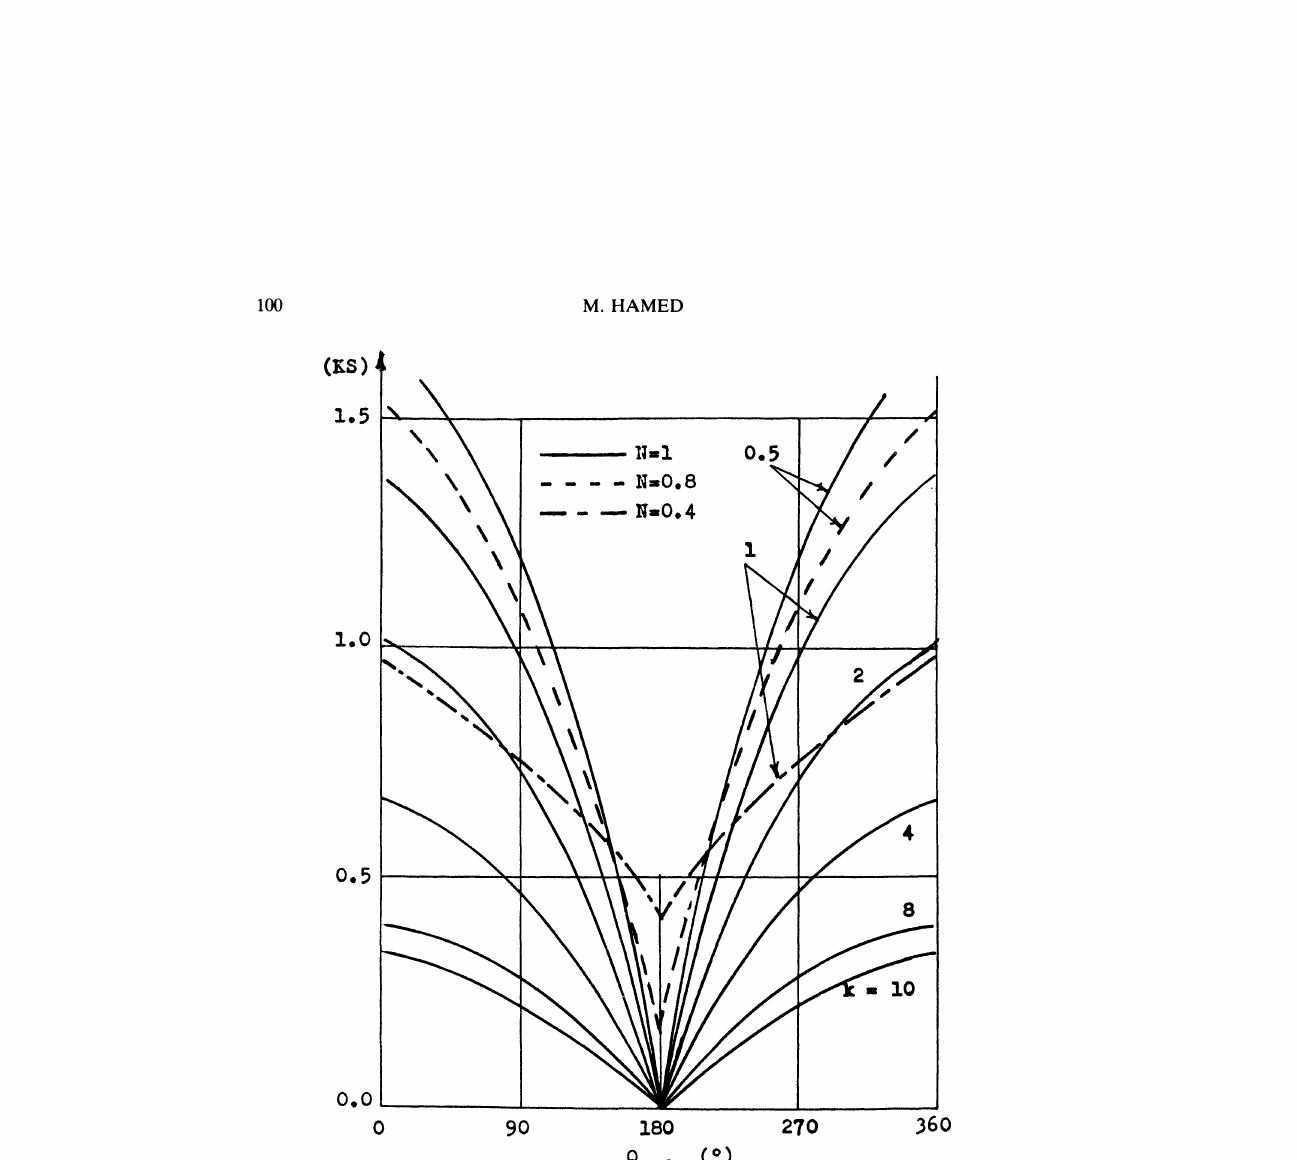
FIGURE 10 The relationship between values of coefficient KS and factors k and Q at different current ratios. absolute magnitude of the vector KS at different ratios of currents for various values of ratio k. For smaller ratios of currents (0.01 and 0.1), the calculated absolute values of variable KS are listed